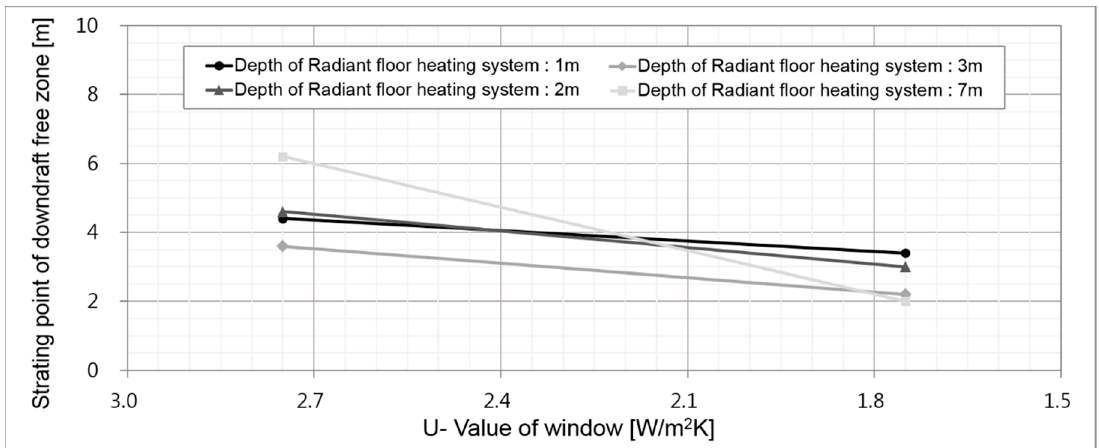
Figure 17. The relationship between RFHS and discomfort (the point when the draft rate falls below class A).